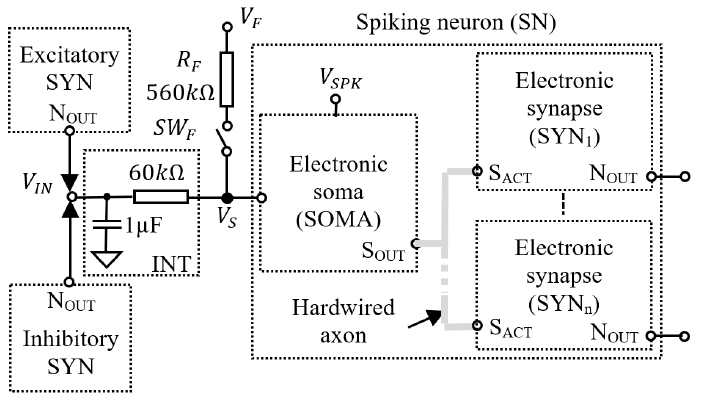
Figure 2. The structure of the electronic neuron that includes one SOMA and more synapses SYN 1 , . . . , SYN n with n ≥